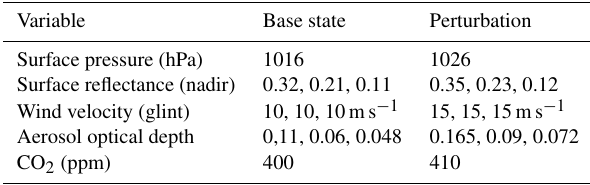
Table 3. Input to SHDOM calculations ∗